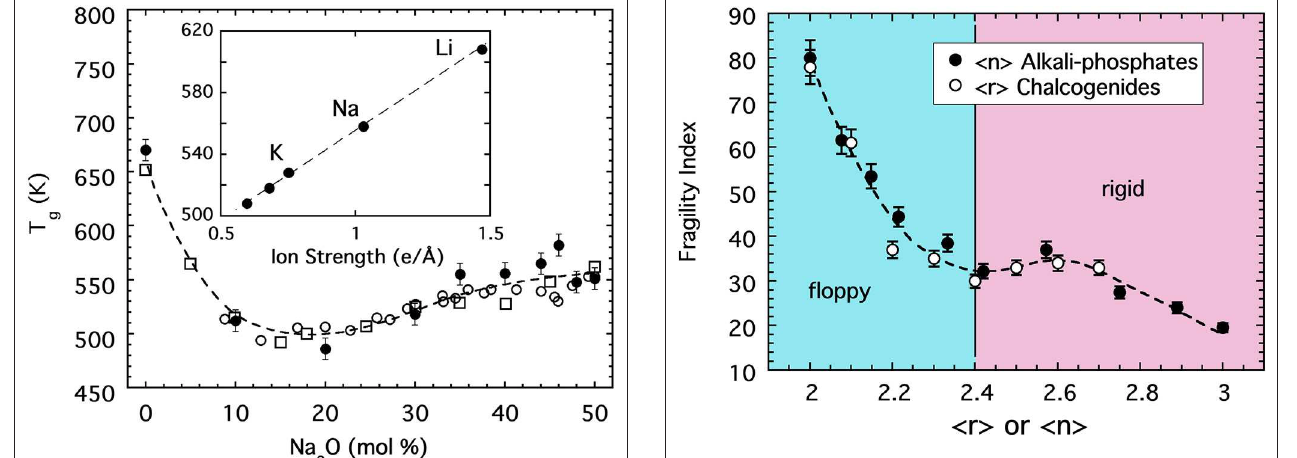
FIGURE 4 | The fragility index of alkali phosphate melts (closed circles) plotted as a function of the average number of bridging oxygen per PO 4 tetrahedra alongside the fragility index of chalcogenide melts (Tatsumisago et al., 1990) plotted as a function of the average bond per atom. The value of h r i = 2.4 marks the rigidity transition separating under-constrained floppy networks from over-constrained rigid